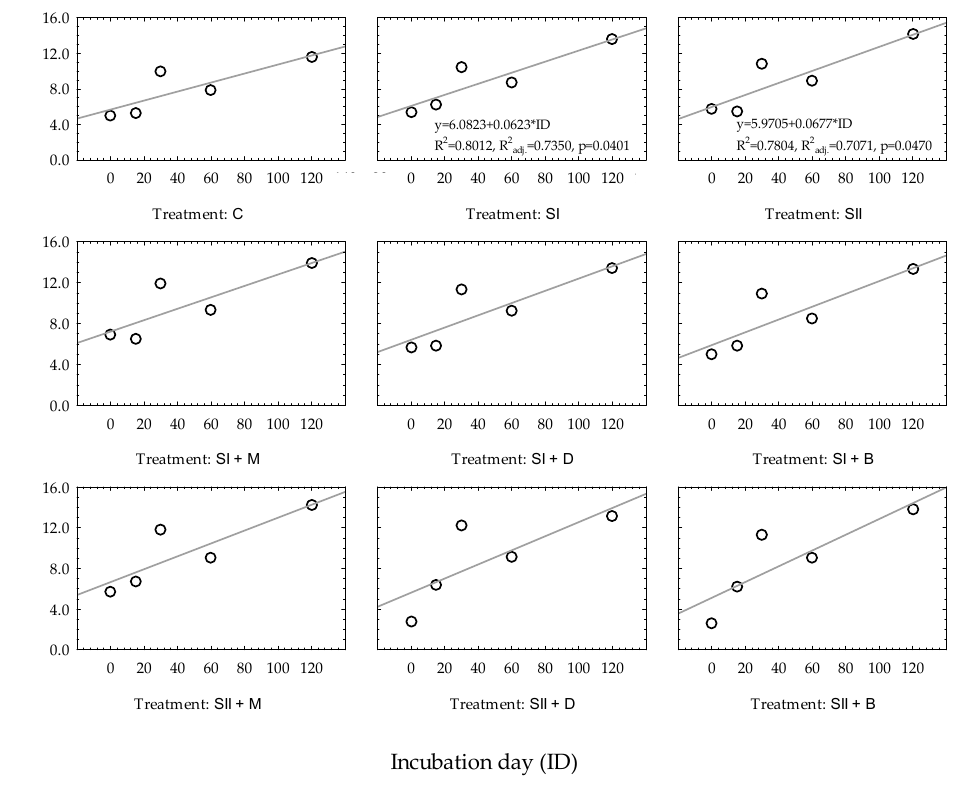
Figure 3. Linear regression models of Mn changes over time based on experimental treatments in heavy soil. Regression equations are presented only when p ≤ 0.05. * constitute a multiplication mark.